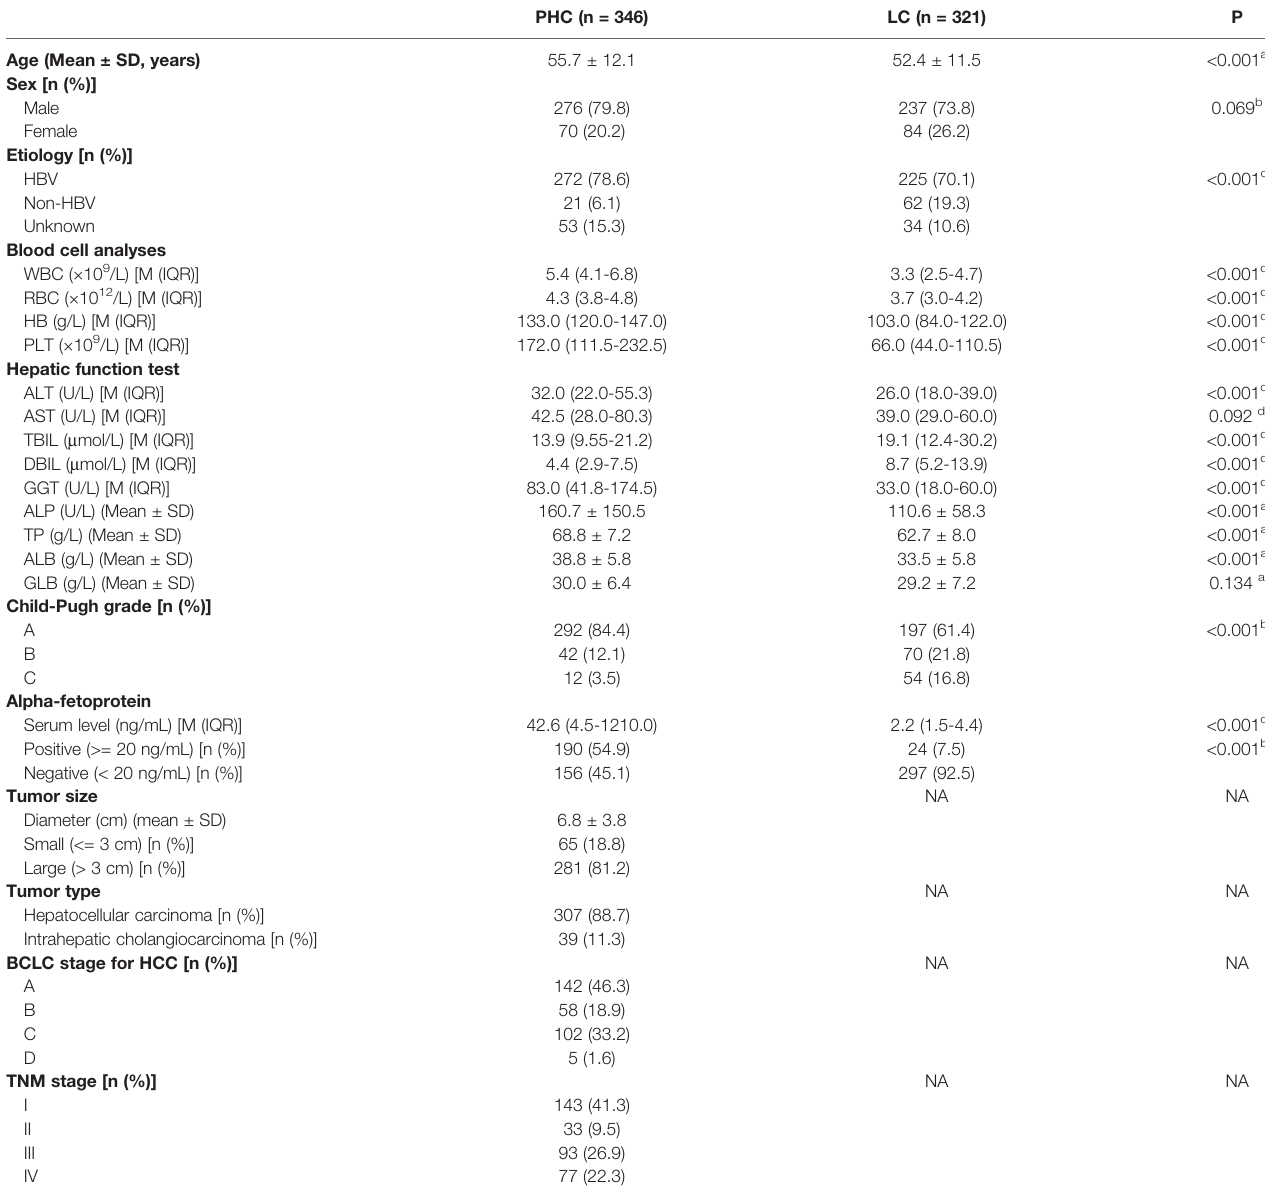
TABLE 1 | The demographic and clinical characteristics of